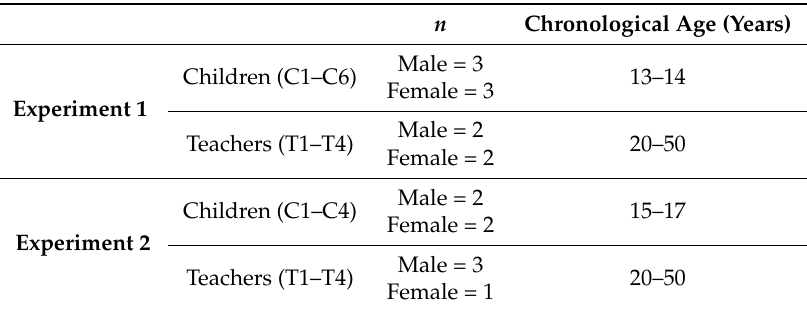
Table 4. Participants in the field